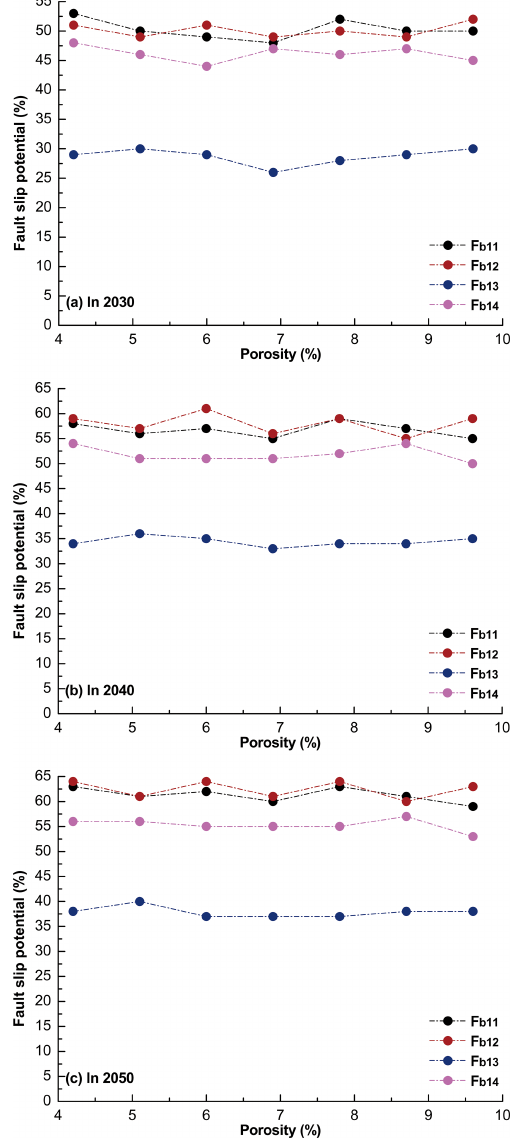
Figure 15. The effect of porosity on probabilistic fault slip potential on the mapped faults F b11 , F b12 , F b12 , and F b14 , within a range of ∼ 6–10km away from the MTY EGS